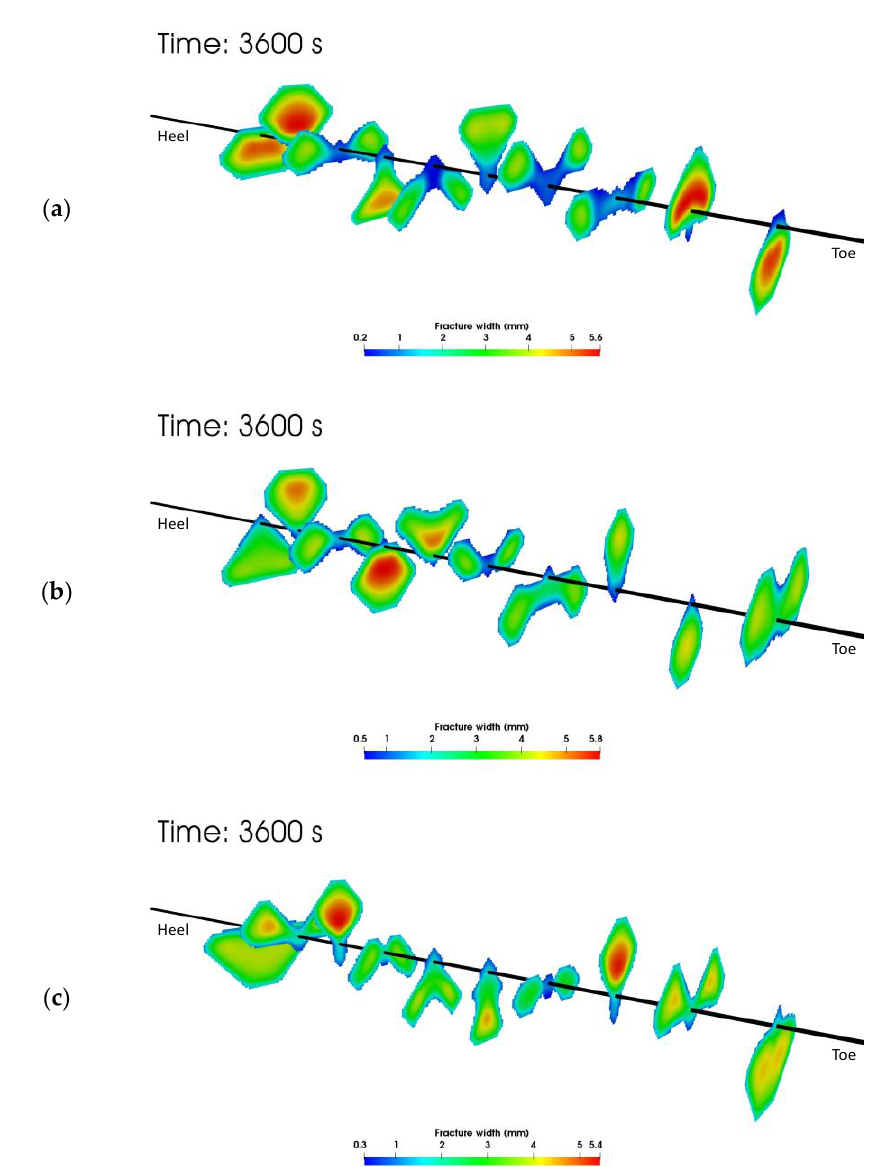
Figure 9. Fracture width distribution at the end of the one-hour injection. The axis scales along the wellbore direction have been exaggerated 6 times. ( a ) Case using slick water, ( b ) Case using NG foam, ( c ) Case using hybrid NG and NG foam.